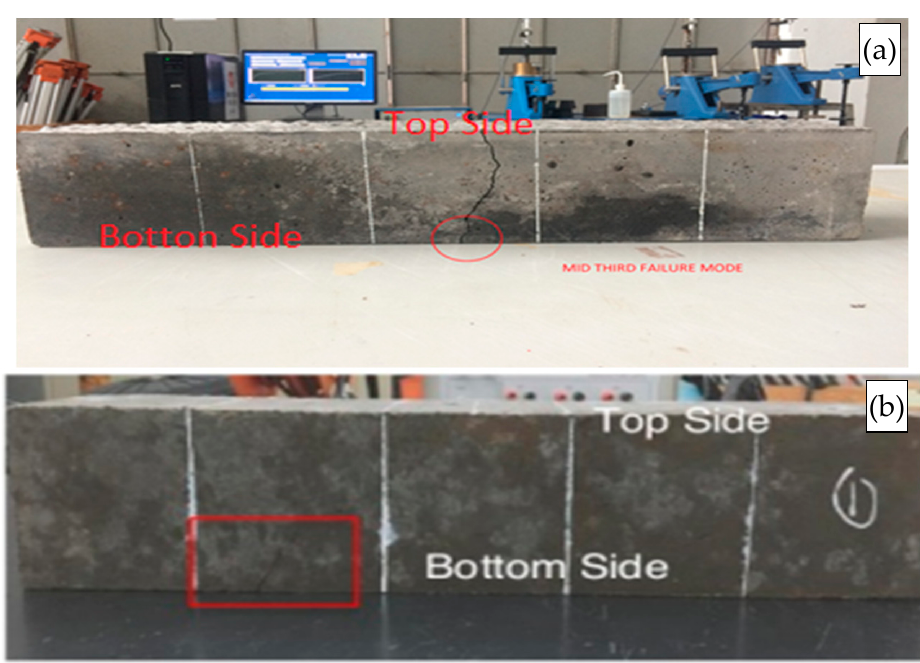
Figure 6. Typical failure of flexural test: ( a ) within central region and ( b ) outside central region.